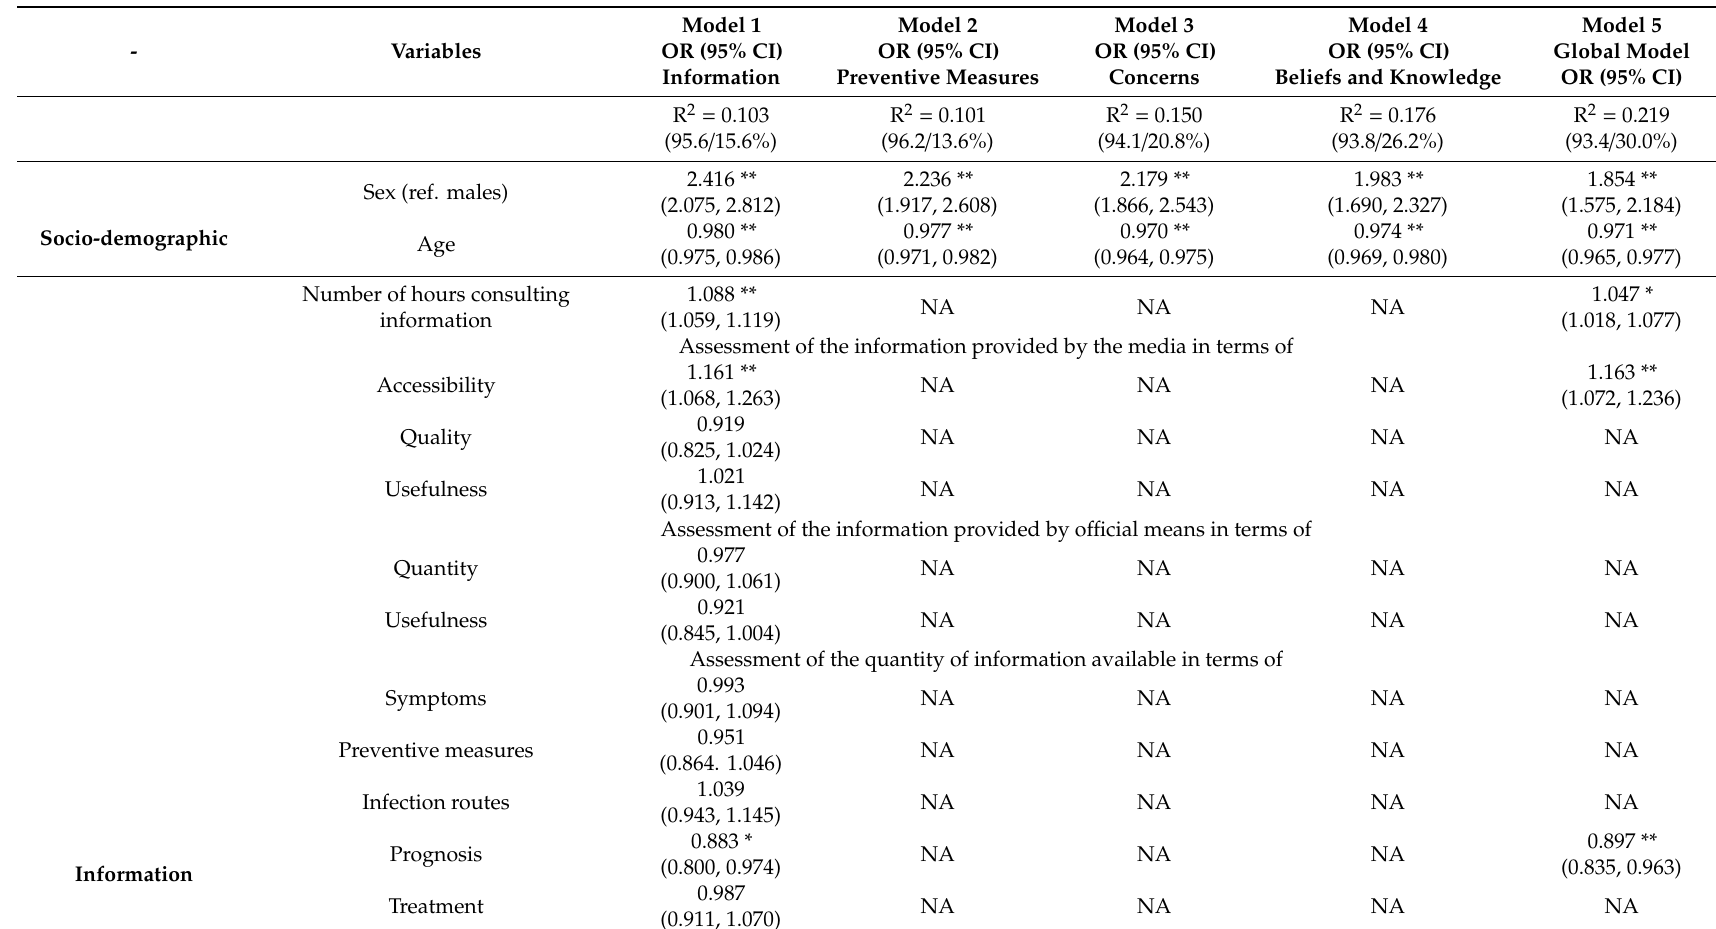
Table 6. Logistic regression models on psychological distress by set